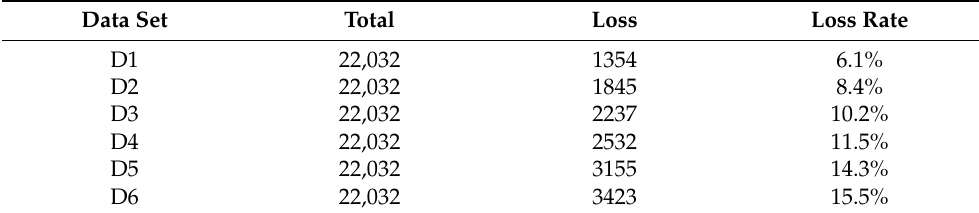
Table 1. Statistics of gas concentration data at each monitoring point.